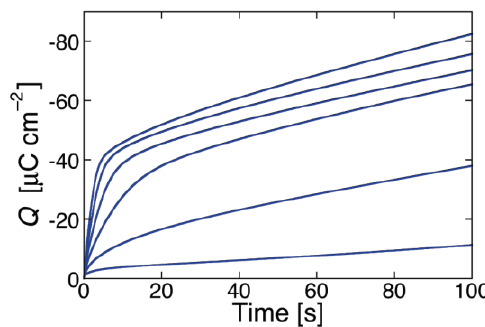
Figure 11. Charge transients at a DPTL/DOPC tBLM in a pH 6.8 buffer solution of 0.1 M KCl and 0.4 μg/mL SP25A, obtained by jumping from E i = −0.30 V to final potentials varying from −0.50 to −1.00 0.4 µ g/mL SP25A, obtained by jumping from E i = − 0.30 V to final potentials varying from − 0.50 V by −100 mV increments. (Reprinted with permission from [18]. Copyright 2015, Elsevier).